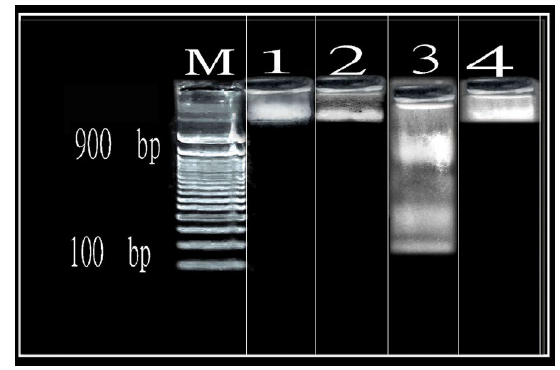
Fig. 4 Photomicrograph of an agarose gel showing an evident variation of the DNA fragmentation in the hepatic tissue extract of 20‑day‑old rat fetuses treated with labetalol with/without ginger. bp: base pair, M: marker DNA (100 bp DNA Ladder, New England Bio‑labs, Ipswich, MA, USA), 1: control, 2: ginger, 3: labetalol and 4: labetalol